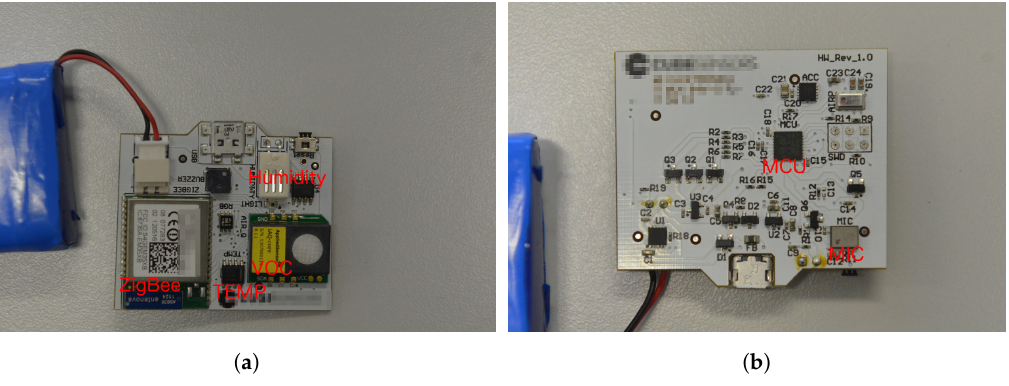
Figure 3. The sensor node. ( a ) The top side of the node’s PCB. It contains the humidity sensor, the VOC sensor, the temperature sensor and the ZigBee transceiver. ( b ) The bottom side of the node’s PCB. It contains the ARM Cortex TM -M0 MCU and the SiSonic